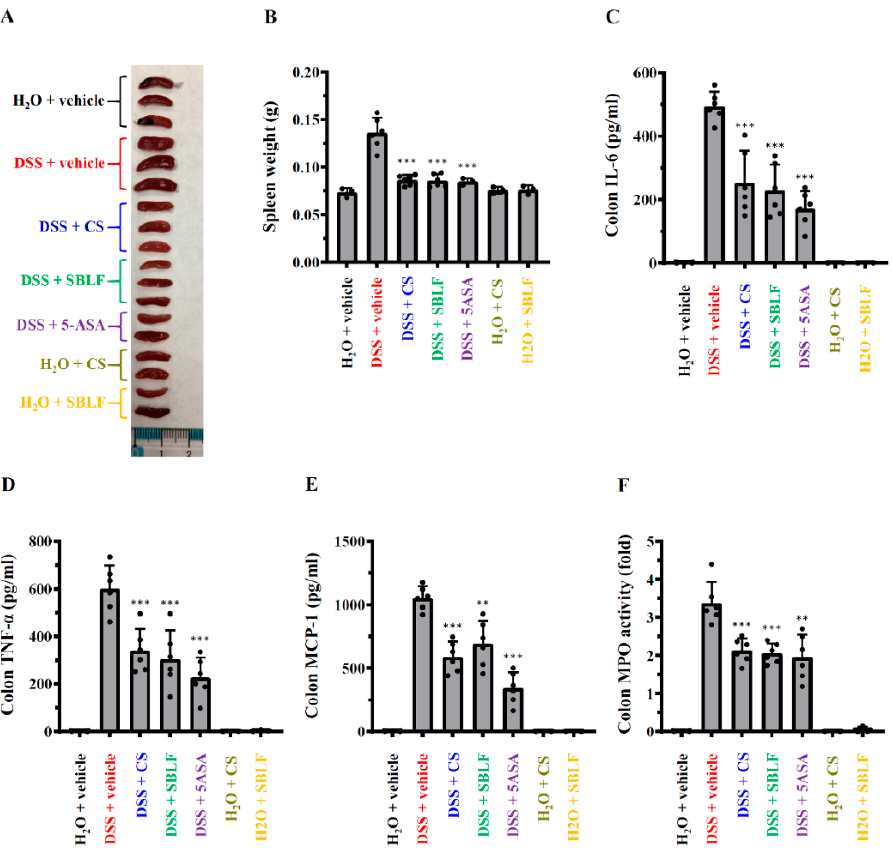
Figure 3. SBLF improves inflammation in DSS-treated mice. ( A ) Images of representative splenomegaly of mice. ( B ) Bars represent the spleen weight of mice. ( C ) The levels of IL-6 in colon tissue. ( D ) TNF- α concentration in colon tissue. ( E ) MCP-1 concentration in colon tissue. ( F ) MPO activity in colon tissue. Bars show the mean ± SD. ** p < 0.01 and *** p < 0.001 compared to vehicle + DSS